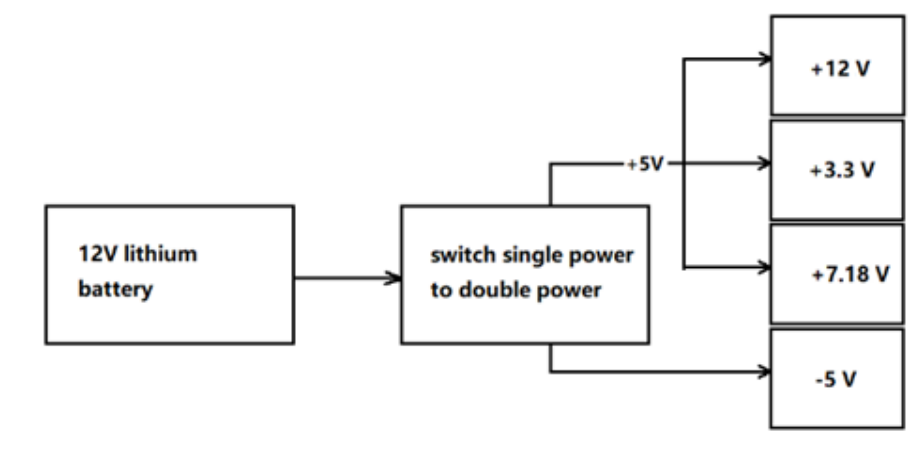
Figure 6. Power module.